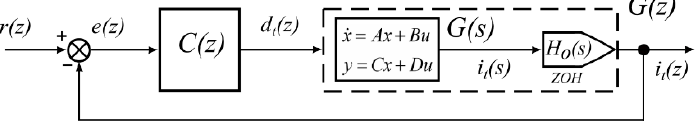
Figure 4. Block scheme of the whole current control system.